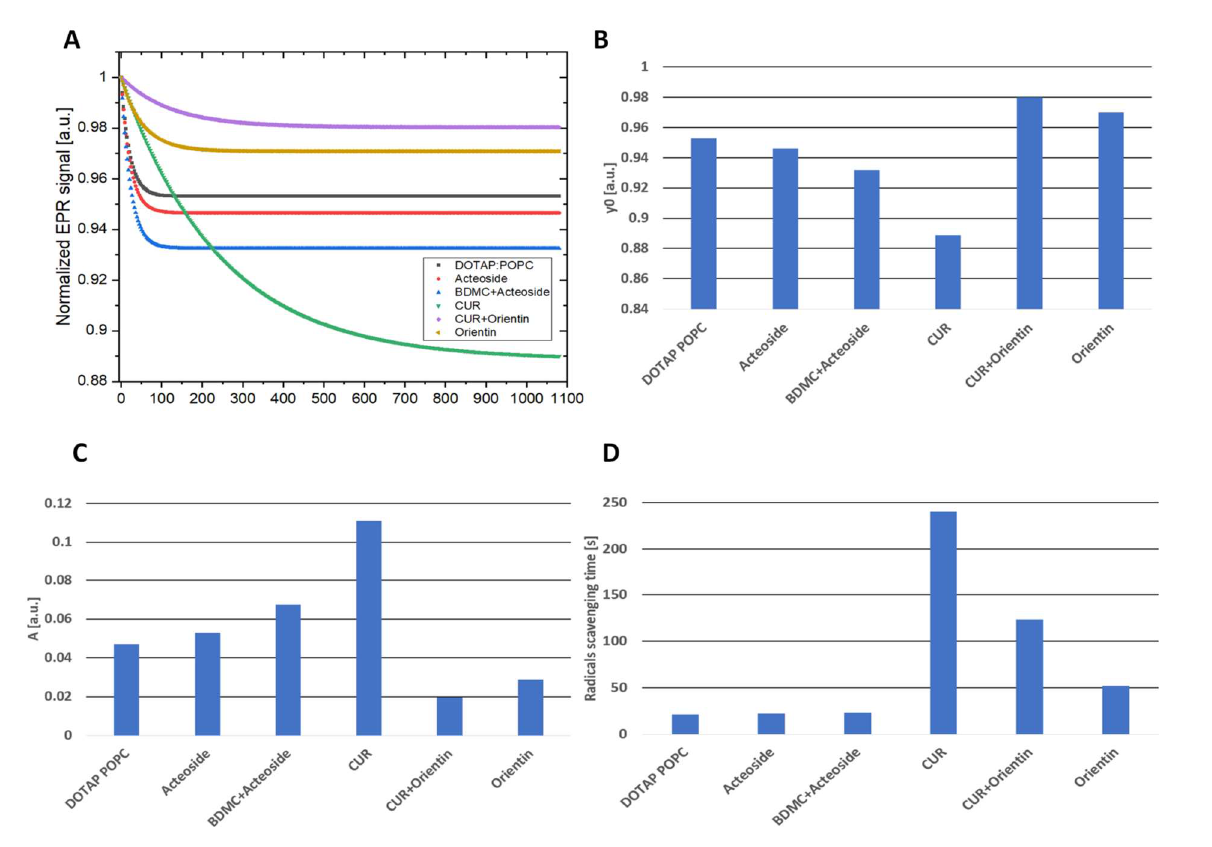
Figure 9. ( A ) L band radical scavenging results. ( B ) The number of remaining radicals of the 3CPy spin probe after mixing with the liposomal formulations (in arbitrary units). ( C ) The amount of the swept-off radicals of the 3CPy spin probe after mixing with the liposomal formulations (in arbitrary units). ( D ) The scavenging reaction time in seconds; CUR—curcumin, BDMC—bisdemethoxycur- cumin.